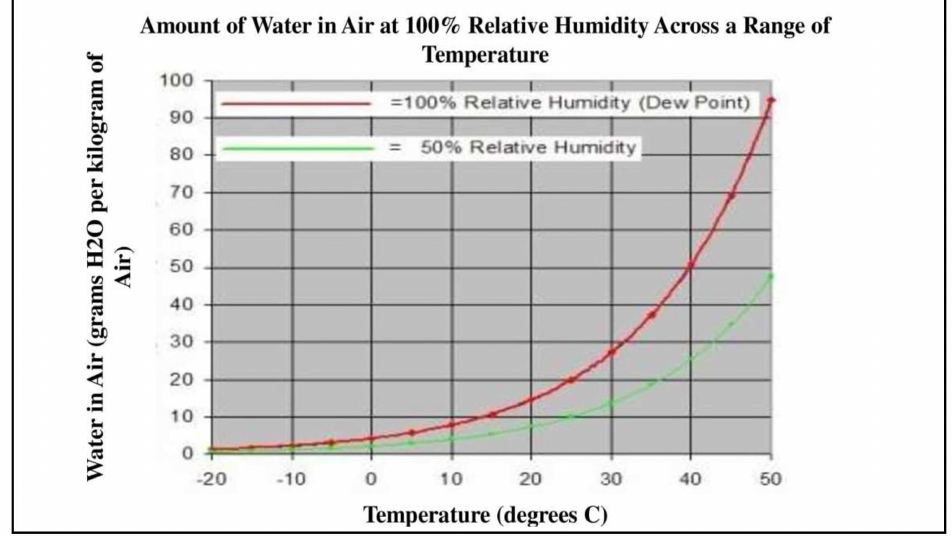
Figure 8. The amount of water in air at 100% relative humidity across a range of